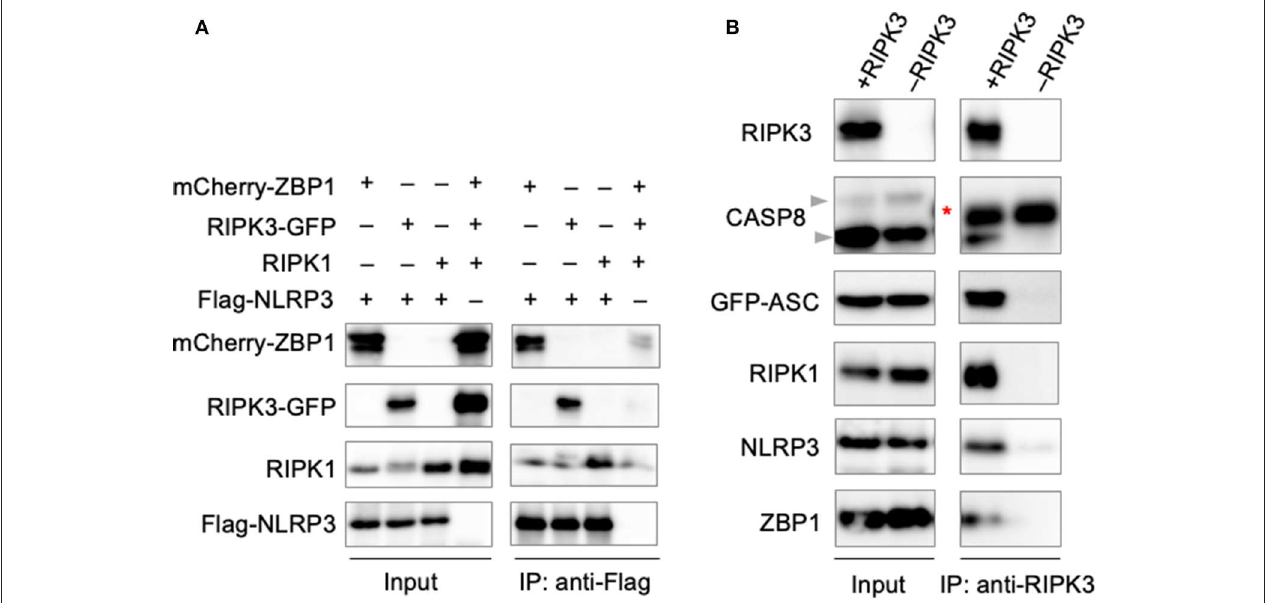
FIGURE 3 | PANoptotic molecules directly interact. (A) Co-immunoprecipitation of NLRP3 expressed in HEK293T cells with ZBP1, RIPK3, and RIPK1 individually. (B) Co-immunoprecipitation of the PANoptosome complex in HEK293T cells expressing CASP8, ASC, RIPK1, NLRP3, and ZBP1 with or without RIPK3. Red asterisks denote a non-specific